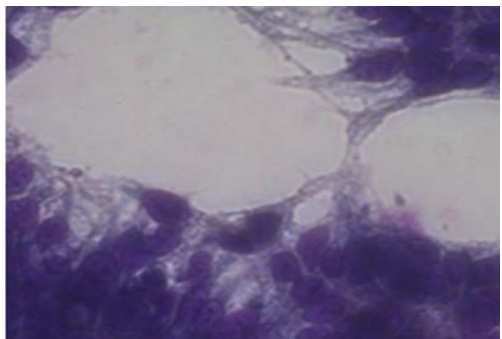
Fig. 5. Blank Caco-2 cell line